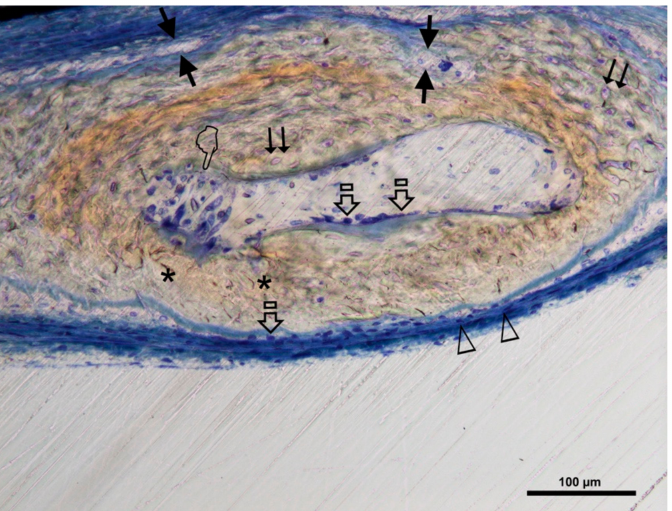
Figure 6. Bone histology image obtained after using Zn-NMs dye with toluidine blue in experimental animals to visualize mineral bone after their healing time. Single arrows point the presence of osteoblast with typical cuboid shape. Double arrows indicate osteocytes, pointers mean osteoclast and faced arrows point blood vessels. Asterisk are located close by canaliculi. Arrow heads signal the presence of